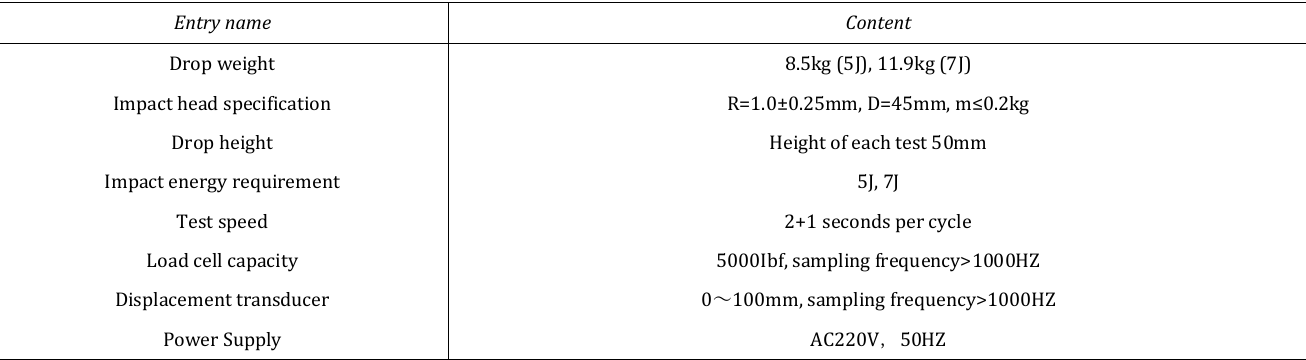
Table 1: Text mining in different personalized recommendation services